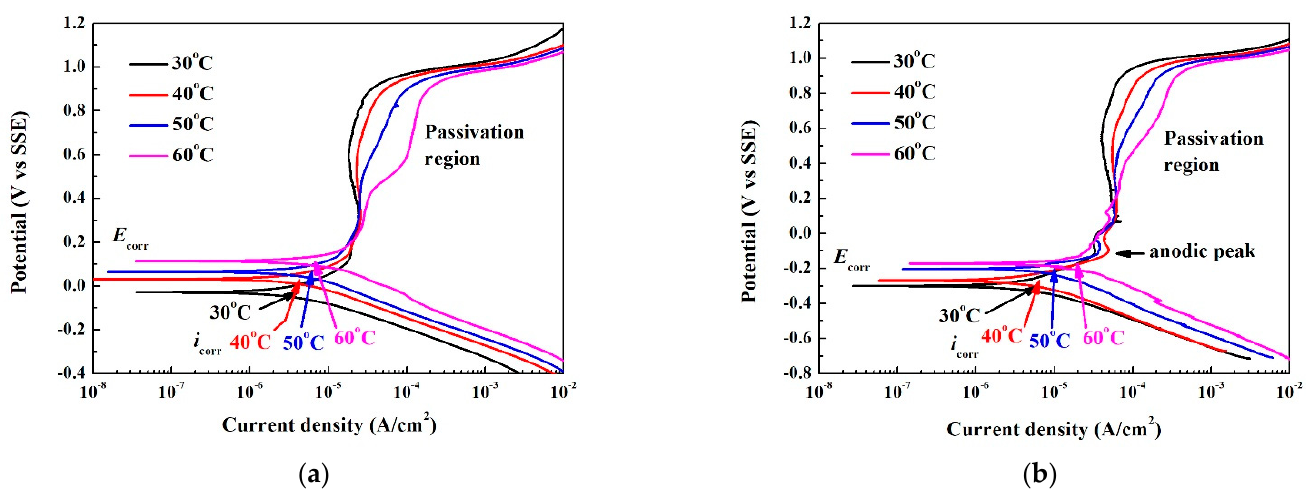
Figure 2. Potentiodynamic polarization curves of Cr 19 Fe 22 Co 21 Ni 25 Mo 13 alloy tested in the deaerated solutions of: ( a ) 1M HNO 3 solution and ( b ) 1M HCl solution under different temperatures. Table 2. Corrosion potentials and corrosion current densities of Cr 19 Fe 22 Co 21 Ni 25 Mo 13 alloy tested under different temperatures.